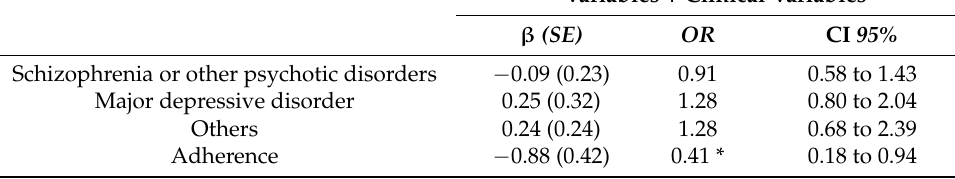
Model: Interventions +